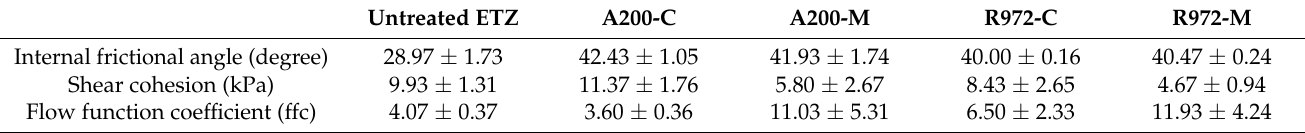
Table 2. Powder flowability parameters of silica nanoparticle-coated ETZ under stress measured by the shear cell method (Nanoseeds constant-volume-type shear tester; NS-S500). Data are presented as means ± standard deviations ( n =